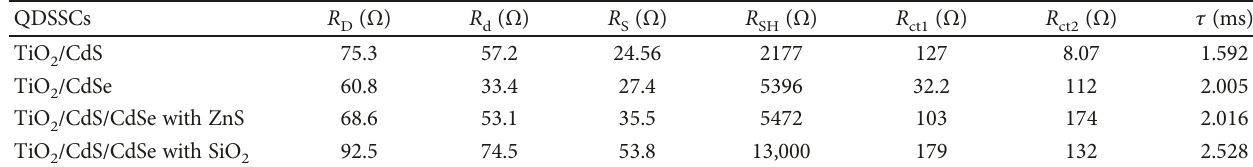
Table 3: Parameters obtained from the EIS measurements and J - V curves.